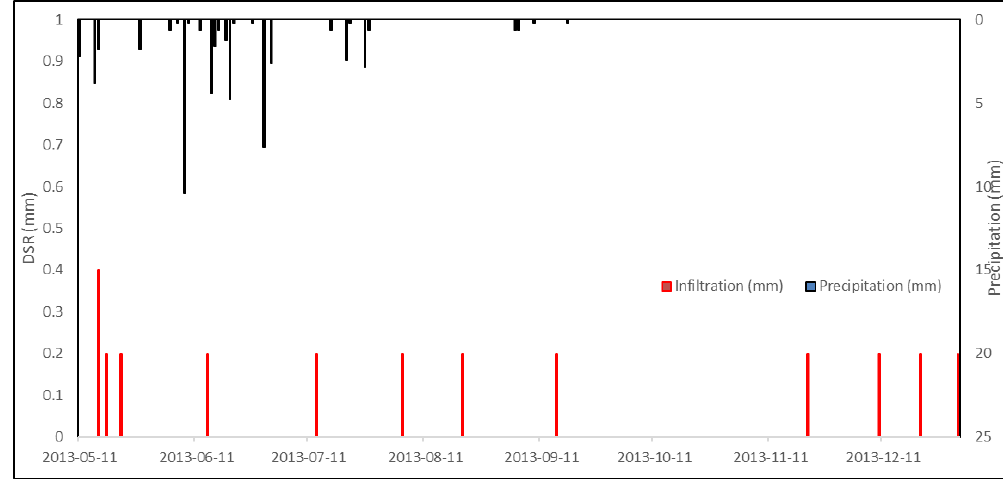
Figure 4. Relationship between precipitation and DSR in 2013 .